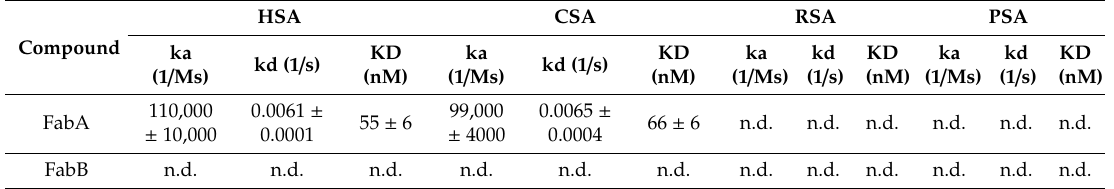
Table 3. Binding kinetics of FabA and FabB to albumin of di ff erent species.